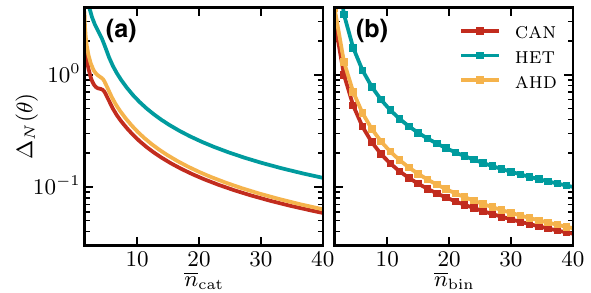
FIG. 5. Comparison of the modular phase uncertainty (cid:17) MEAS (θ) for order N = 3 number-phase codes and different N realizations of the phase measurements. In (a) for cat codes and in (b) for bin codes. The continuous lines in (a) emphasize that cat codes are defined for continuous parameter α (with ) while markers in (b) emphasize that bin codes are α 2 = n cat defined only for discrete values of n bin . Connecting lines in (b) are a guide for the